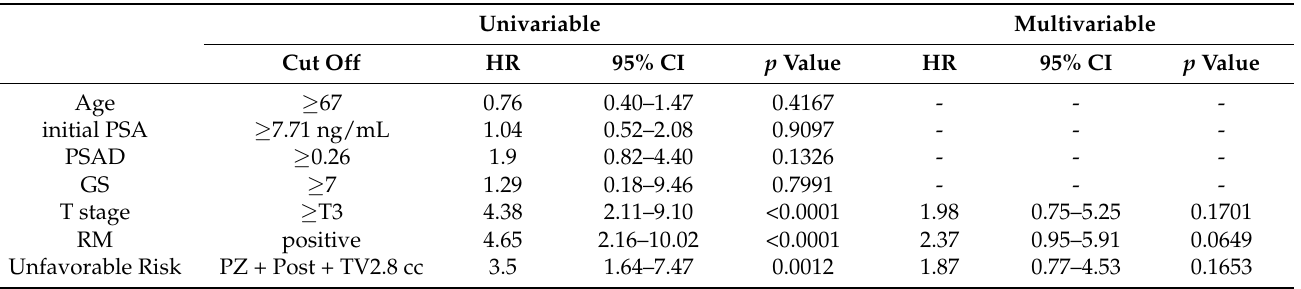
Table 4. Univariable and multivariable cox proportional hazard regression models in predictive factors for PFS in localized Pca (high risk).